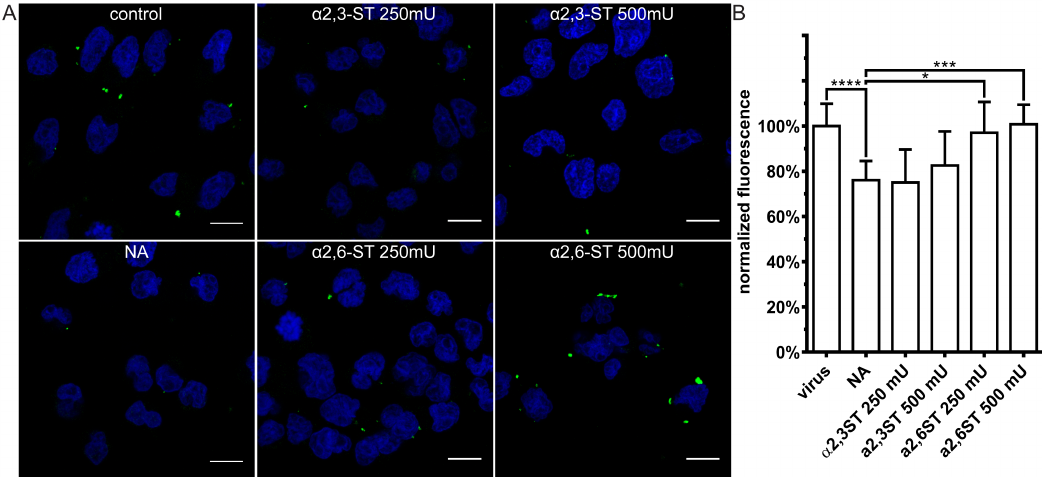
Figure 9. Resialylation restores BCoV attachment to SAs-depleted cells. Cells treated with type II neuraminidase (NA, 500 mU/mL) and overlaid with α -2,3-sialyltransferase ( α 2,3-ST) or α -2,6-sialyltransferase ( α 2,6-ST) in the presence of 1 mM cytidine-5 (cid:48) -monophospho- N -acetylneuraminic acid for 2 h at 37 ◦ C. Next, cells were overlaid with iodixanol-concentrated BCoV, incubated for 2 h at 4 ◦ C, fixed and immunostained. ( A ) Confocal analysis of BCoV attachment in presence of NA and STs. Virions are presented in green, while blue denotes DNA. Scale bar 10 µ m. Data were collected from a minimum of 12 fields of view, from at least two different samples. ( B ) FACS analysis of viral attachment in presence of NA and STs. Graph shows median fluorescence normalized to control. All data is presented as mean ± SD from at least three experiments in triplicates. (* p < 0.05; ** p < 0.01; *** p < 0.001; **** p <